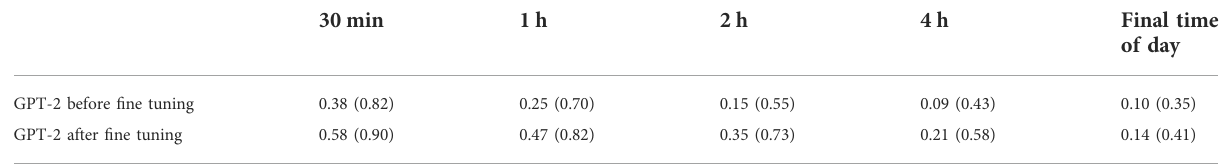
TABLE 2 Probability that the prediction is within 1 km (10 km) of the actual location coordinates for the next half hour, one hour, two hours, four hours, and the end of the day for November 27 and